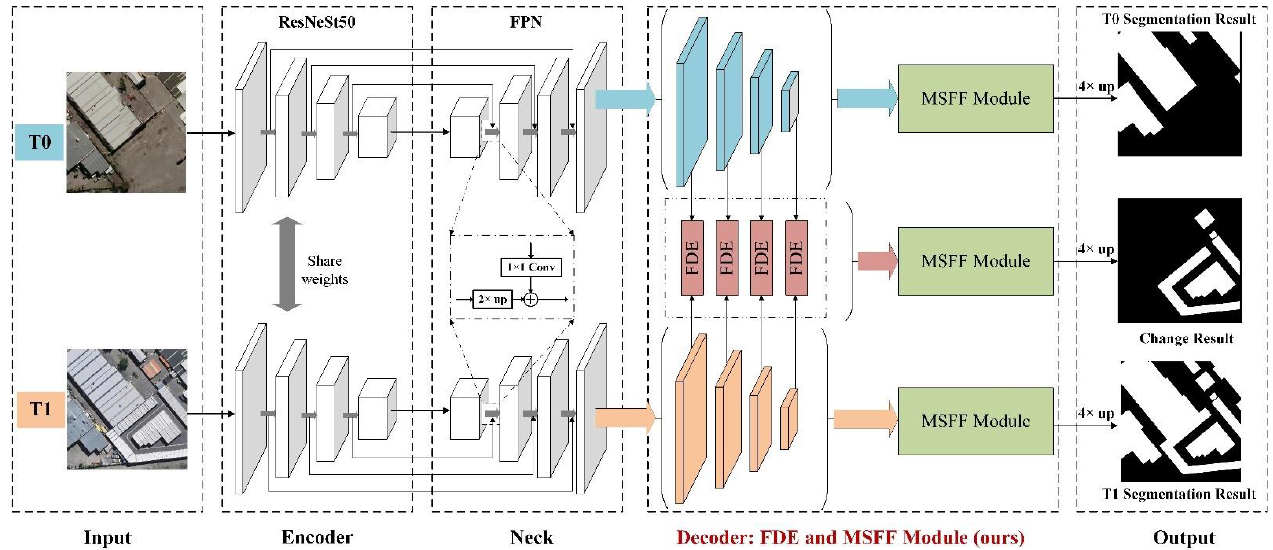
Figure 1. Overview of the proposed MDESNet. The T0 and T1 remote sensing images were inputted into the Siamese network (based on ResNeSt-50), and bitemporal multiscale feature maps were obtained (resolutions are 1/4, 1/8, 1/16, and 1/32 of the input, respectively). Subsequently, these were, respectively, inputted into FPN to fully integrate the context information. The two semantic segmentation branches were decoded using the MSFF module, whereas the change detection branch used the FDE module to obtain multiscale change features, which were then decoded using the MSFF module. Finally, they were restored to the original image resolution using a 4× bilinear up- sampling.